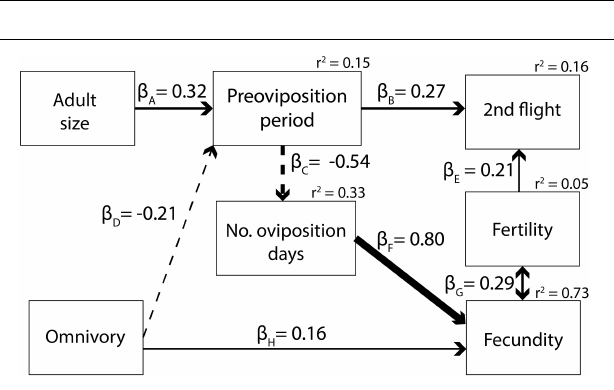
FIGURE 5 | Structural equation model (SEM) of the effects of adult body size (small vs. large) and adult diet, either prey-only or prey plus floral resources (omnivory) on the reproduction and flight performance of female Hippodamia convergens . Solid arrows represent positive causal relationships and dashed arrows, negative causal relationships. Fecundity is the number of eggs laid per female in 18 days of oviposition. Preoviposition period is the number of days from addition of Schizaphis graminum to the diet to first oviposition. No. oviposition days is the number of days on which clutches were laid in the 18-day observation period. Second flight distance was the distance flown by females after the 18-days oviposition period while tethered on a flight mill for 3 h. Fisher’s C = 10.49, df = 22, P =